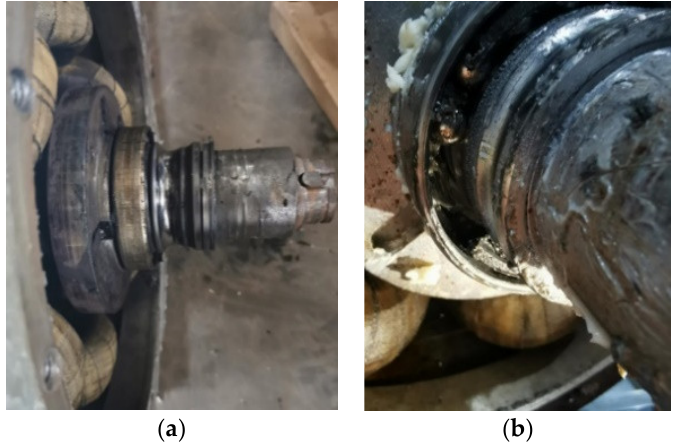
Figure 1. A damaged rotating shaft and bearing due to shafting vibration. ( a ) The damaged rotating shaft. ( b ) The damaged bearing.